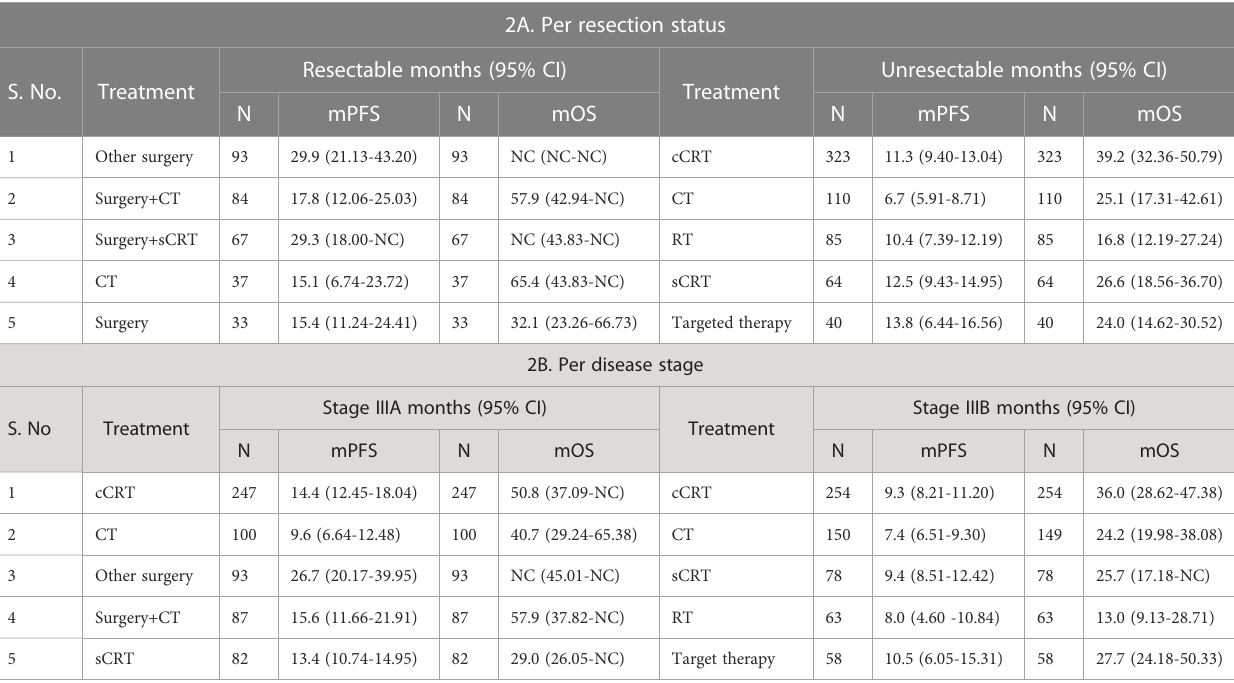
TABLE 2 Survival outcomes with top initial treatment patterns according to resection status and disease stage (AJCC 7 th Edition) in KINDLE-Asia. 2A. Per resection status